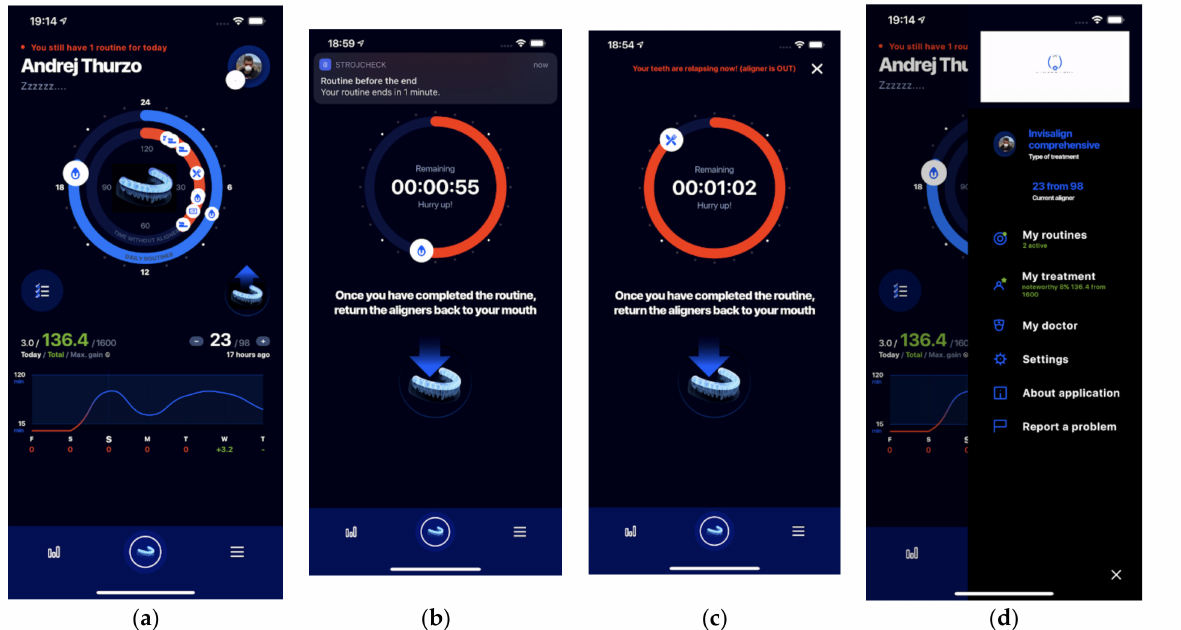
Figure 2. Main screens of orthodontic smart-app StrojCHECK ® : ( a ) Main dashboard of the app provides complex view of the current day, remaining time, planned and executed activities, lower chart visualizes daily performance of time of aligners out-of-mouth, above it is current balance of earned points/treatment discount and current number of aligner ( b ) Remainders are frequently send as a push notifications to patient mobile and wearable either inquiring if the patient has ended an activity and forgot to return the aligners or is still performing the activity. ( c ) An activity can be finished by active patient interaction (with bonus) or automatically (with sanction) ( d ) Side menu allows user to personalize the app, set up scheduled routines, language, learn about his own performance or contact his doctor directly reporting an